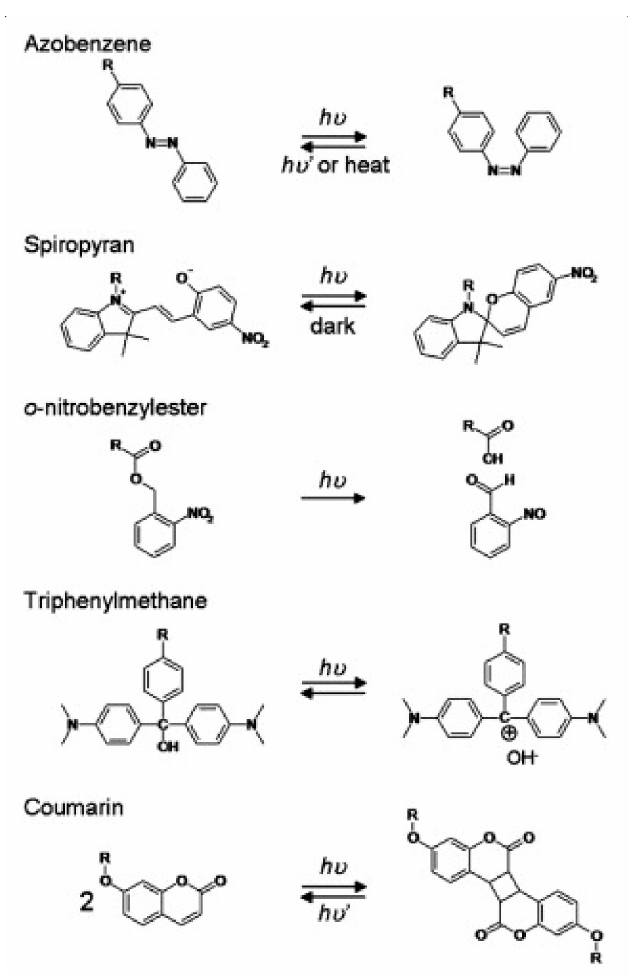
Figure 5. Representative photoreactive moieties used in photoresponsive hydrogels systems. Copy- right (2011) Elsevier B.V. Source: